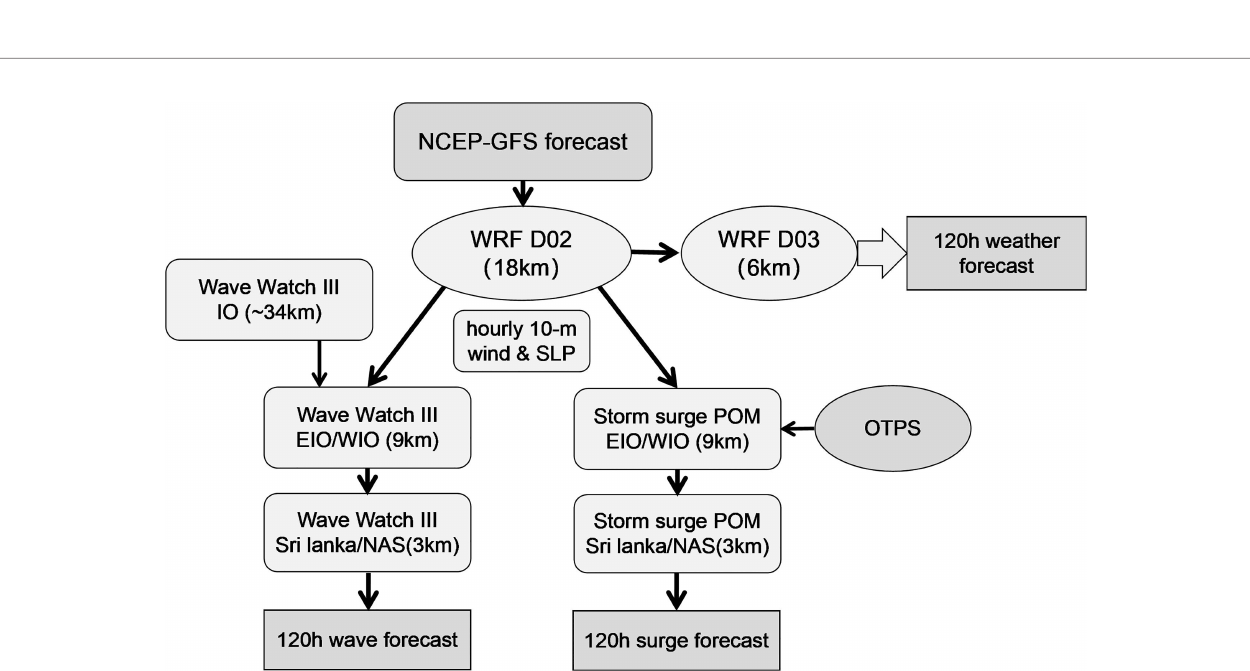
FIGURE 2 | Nesting domains of the ocean wave model for the EIO and WIO.